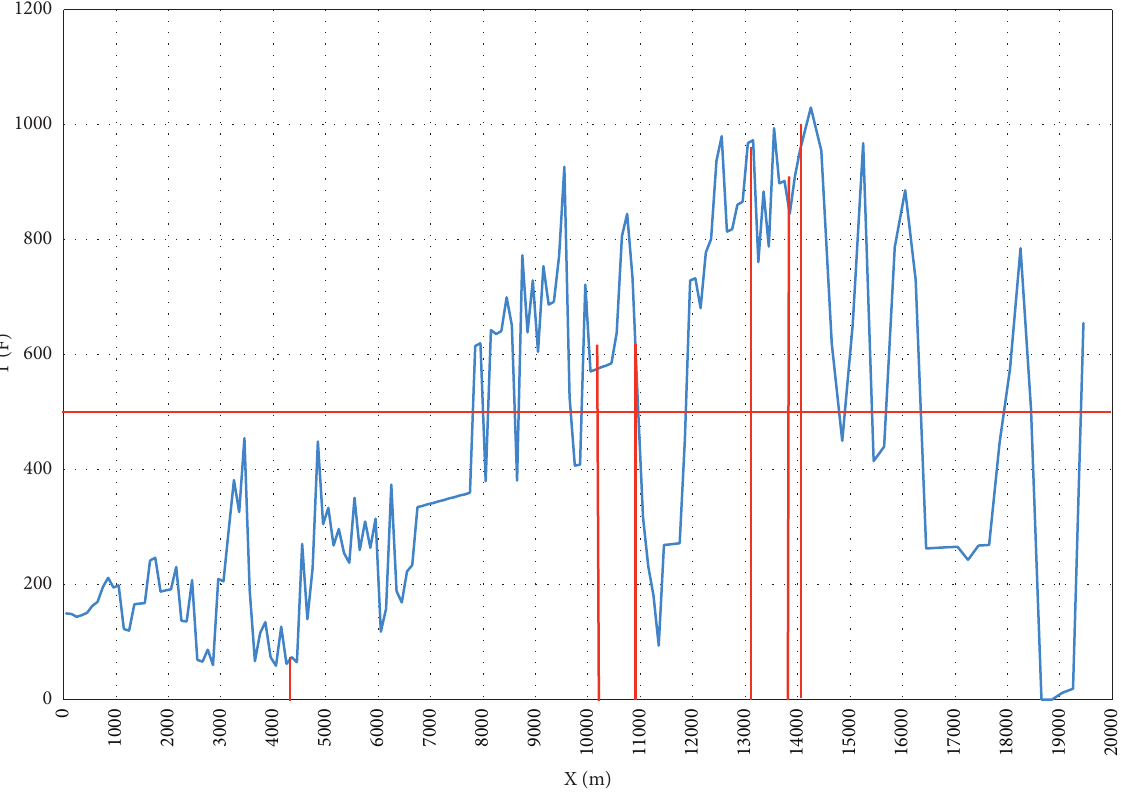
Figure 3: Brake temperature diagram along the route towards Sanandaj city.